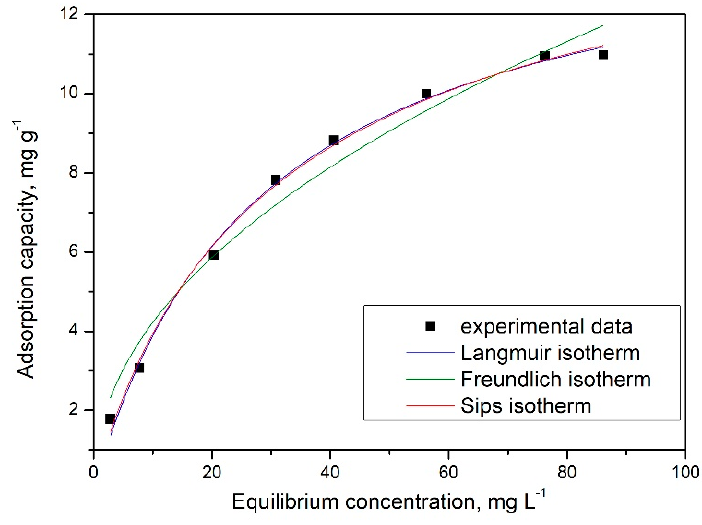
Figure 16. Equilibrium isotherms obtained after experimental data modelling with adsorption iso- therm.